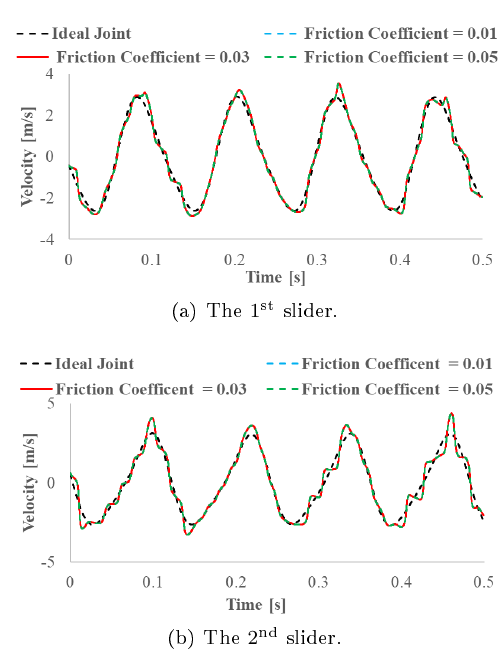
Fig. 5: Velocity of two sliders.